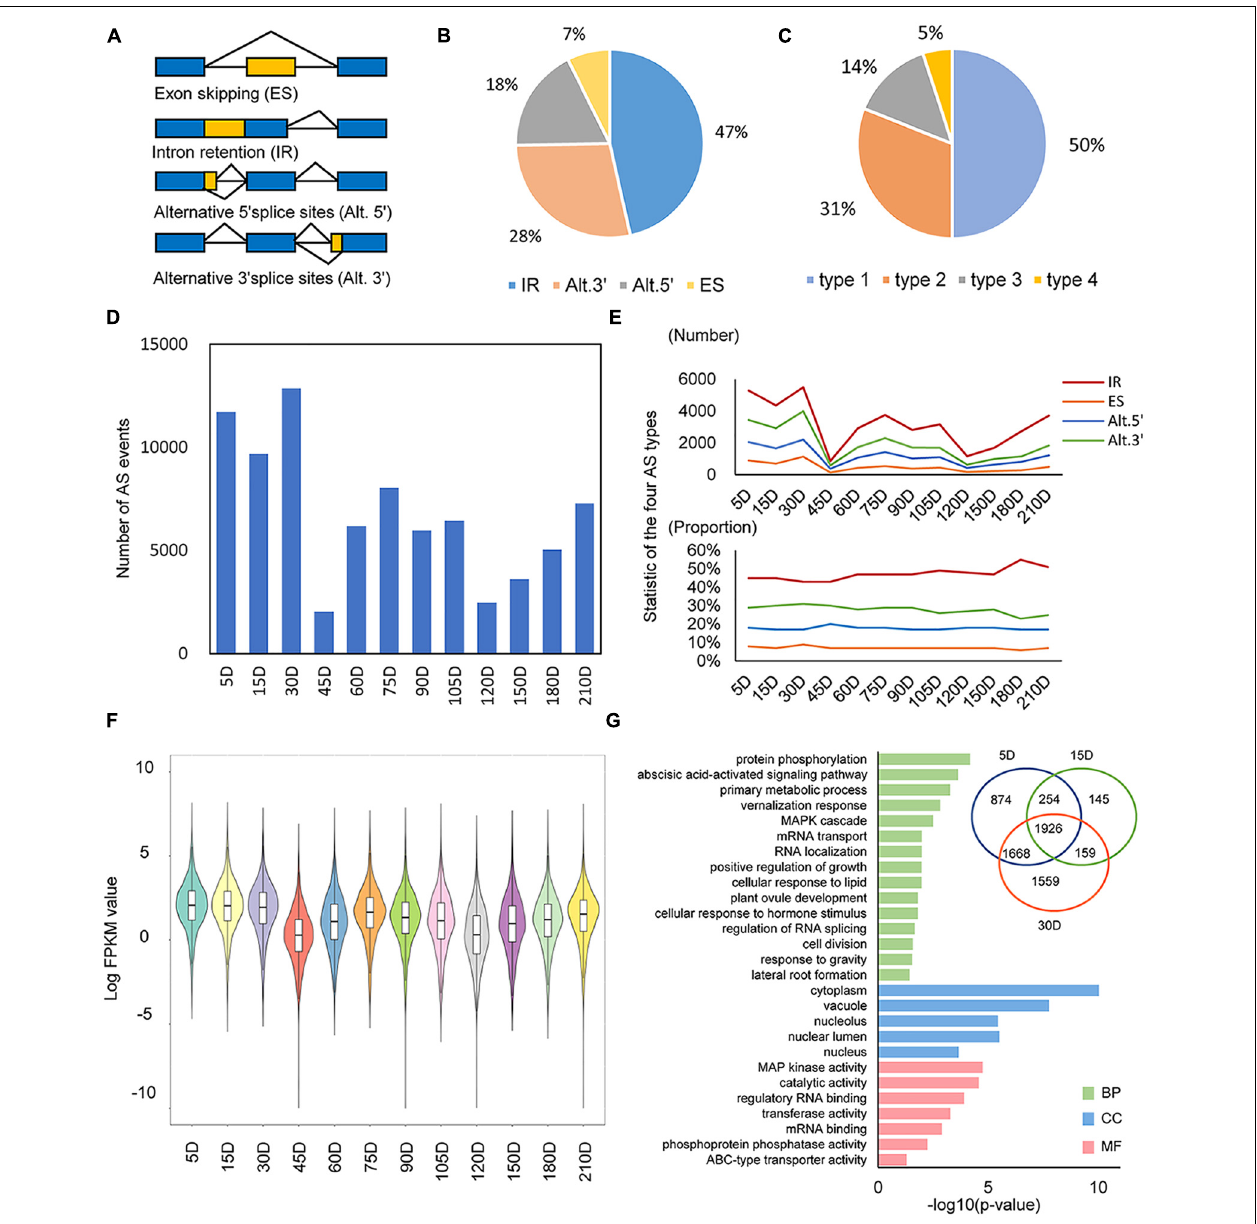
FIGURE 1 | AS dynamics during the life-cycle of Salvia miltiorrhiza . (A) The representative forms of alternative splicing (AS), namely, exon skipping (ES), intron retention (IR), alternative 5 (cid:48) splice sites (Alt.5 (cid:48) ), and alternative 3 (cid:48) splice sites (Alt.3 (cid:48) ). (B) The proportion of each type of alternative splicing event. (C) The proportion of genes with multiple alternative splicing types. (D) Numbers of AS events in temporal dynamics. (E) Number and proportion of four types of AS events in temporal dynamics. (F) Violin plot of all expressed AS genes in the whole developmental stages. (G) Most significantly enriched GO terms for the first three period genes. Bar plots of –log 10 transformed p are shown. BP, biological process; CC, cellular component; MF, molecular